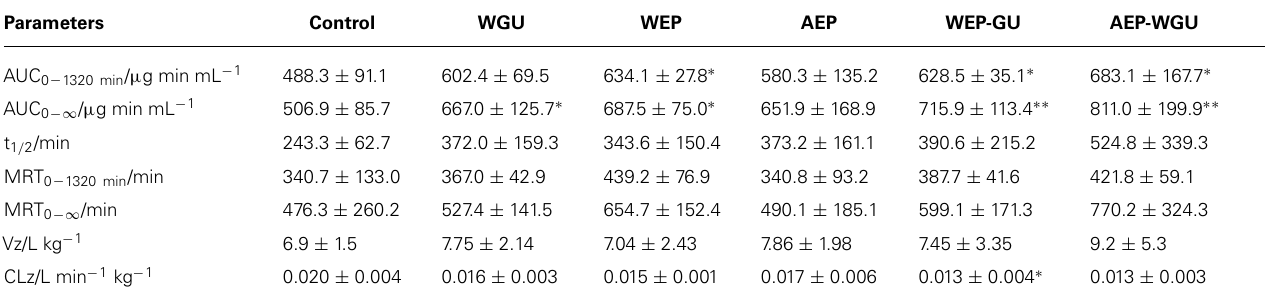
Table 2 | Main pharmacokinetic parameters of 4-hydroxy tolbutamide in rats ( ¯ x ± s, n = 6). Parameters